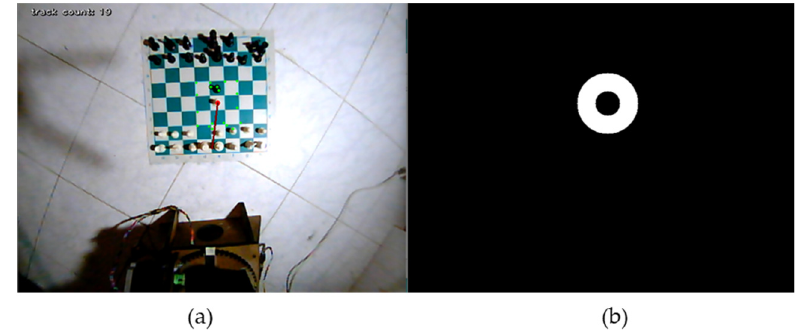
Figure 10. ( a ) Tracking the point of interest (red) using reference points (green). ( b ) The mask used to find reference